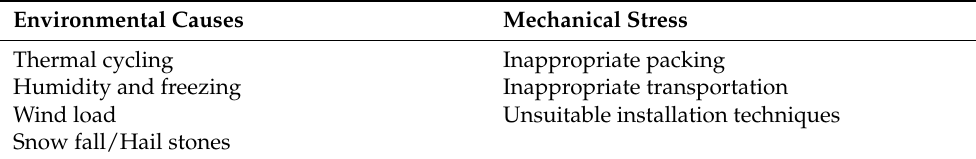
Table 3. Causes of